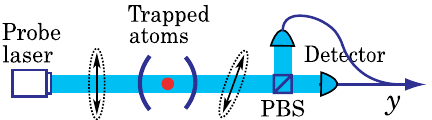
FIG. 4. Atomic ensemble under continuous measurement via Faraday rotation. PBS denotes a polarizing beam